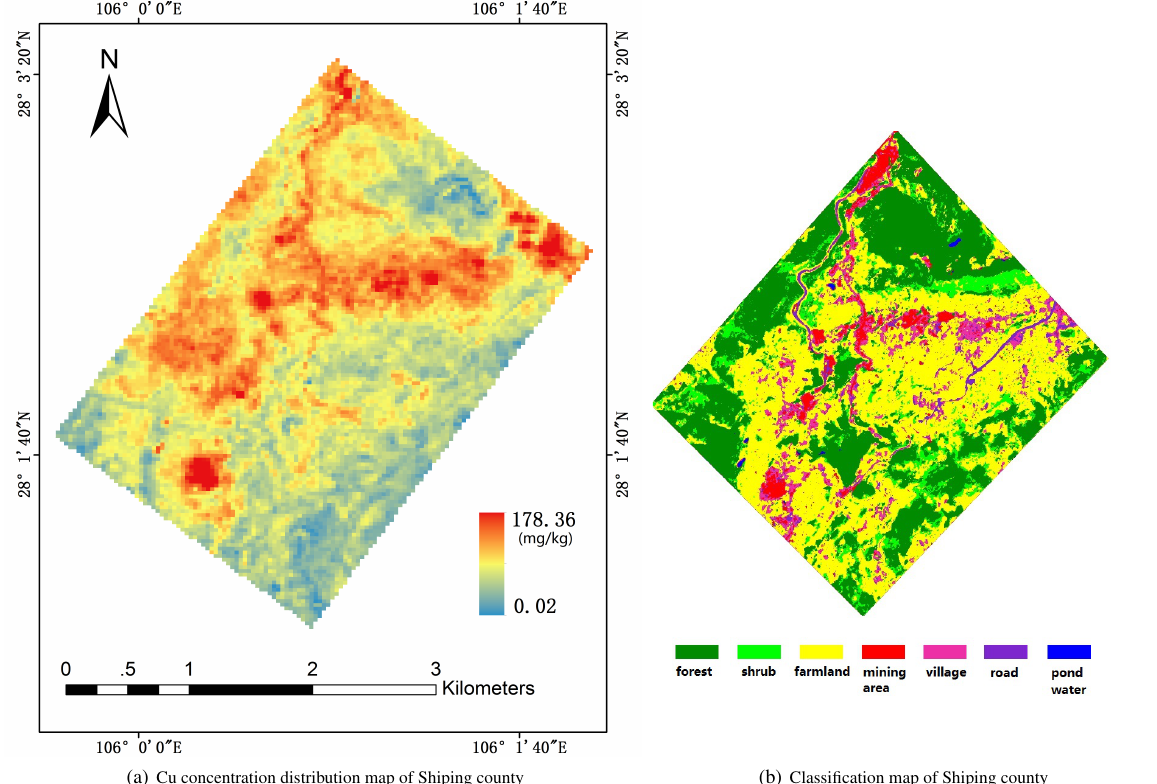
Figure 3. Cu concentration distribution map and classification